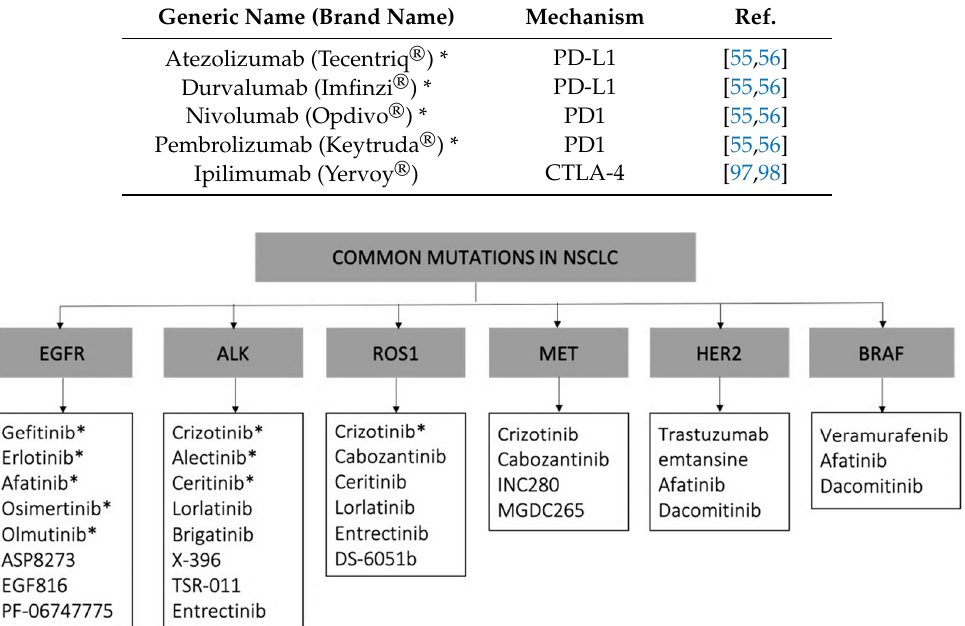
Table 5. Anti-checkpoint inhibitor drugs for NSCLC. * FDA-approved anti-checkpoint inhibitors.